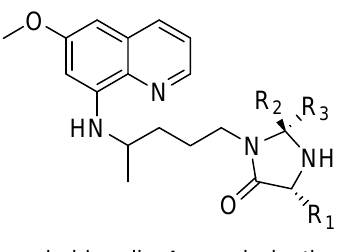
Figure 23 . Chemical structures of imidazolin-4-one derivatives of